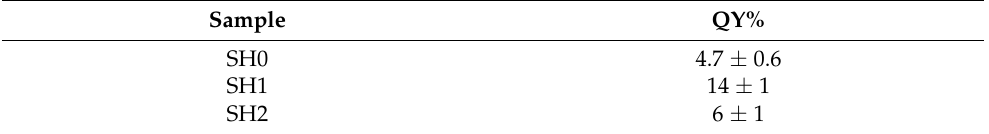
Figure 3. ( a ) Absorption and ( b ) fluorescence spectra ( λ exc = 370 nm) of ZnO-Ts (SH0, SH1, SH2) at different concentrations in PBS-T. ( c ) Corresponding integrated fluorescence intensity versus absorbance at 370 nm; the slopes of the curves were used for calculating the quantum yield (QY) of each sample. Table 2. Relative quantum yield values calculated from Equation (1).